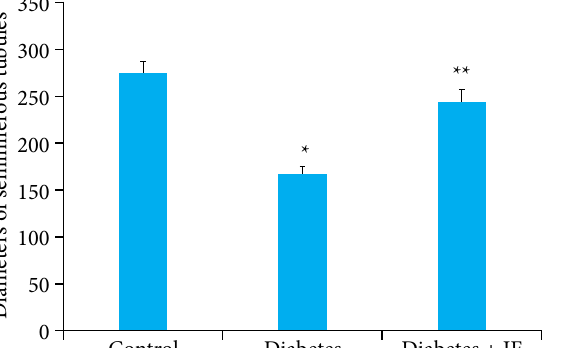
Figure 3 – Seminiferous tubules diameters belonging to control, diabetes, and diabetes+IE groups. *p < 0.001 compared to diabetes group; **p < 0.05 compared to diabetes+IE